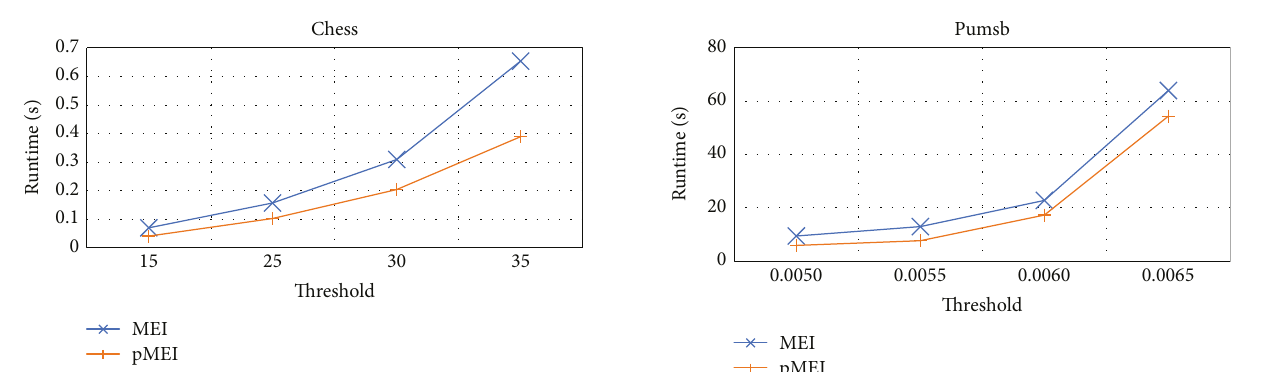
Figure 6: Runtimes of the MEI and pMEI methods on the Pumsb.